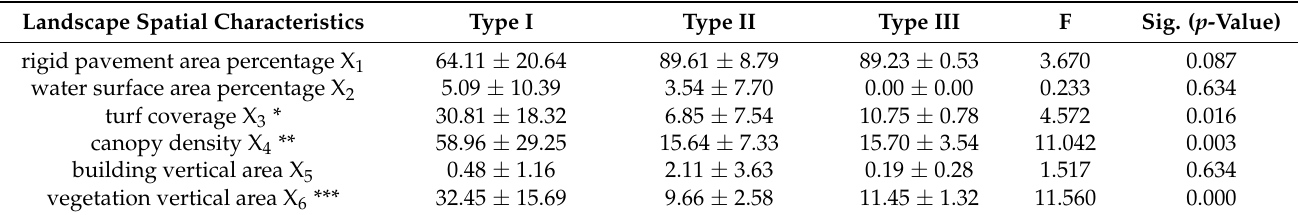
Figure 5. The panoramic view of three types of morning points.